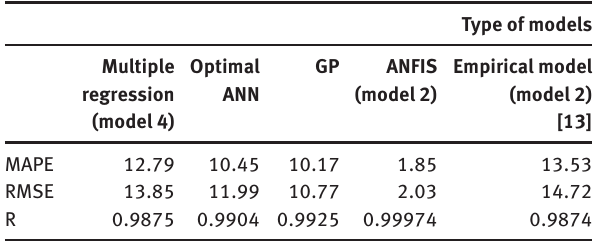
Table 12 Comparison of performance criteria values for MR, ANN, ANFIS, and empirical